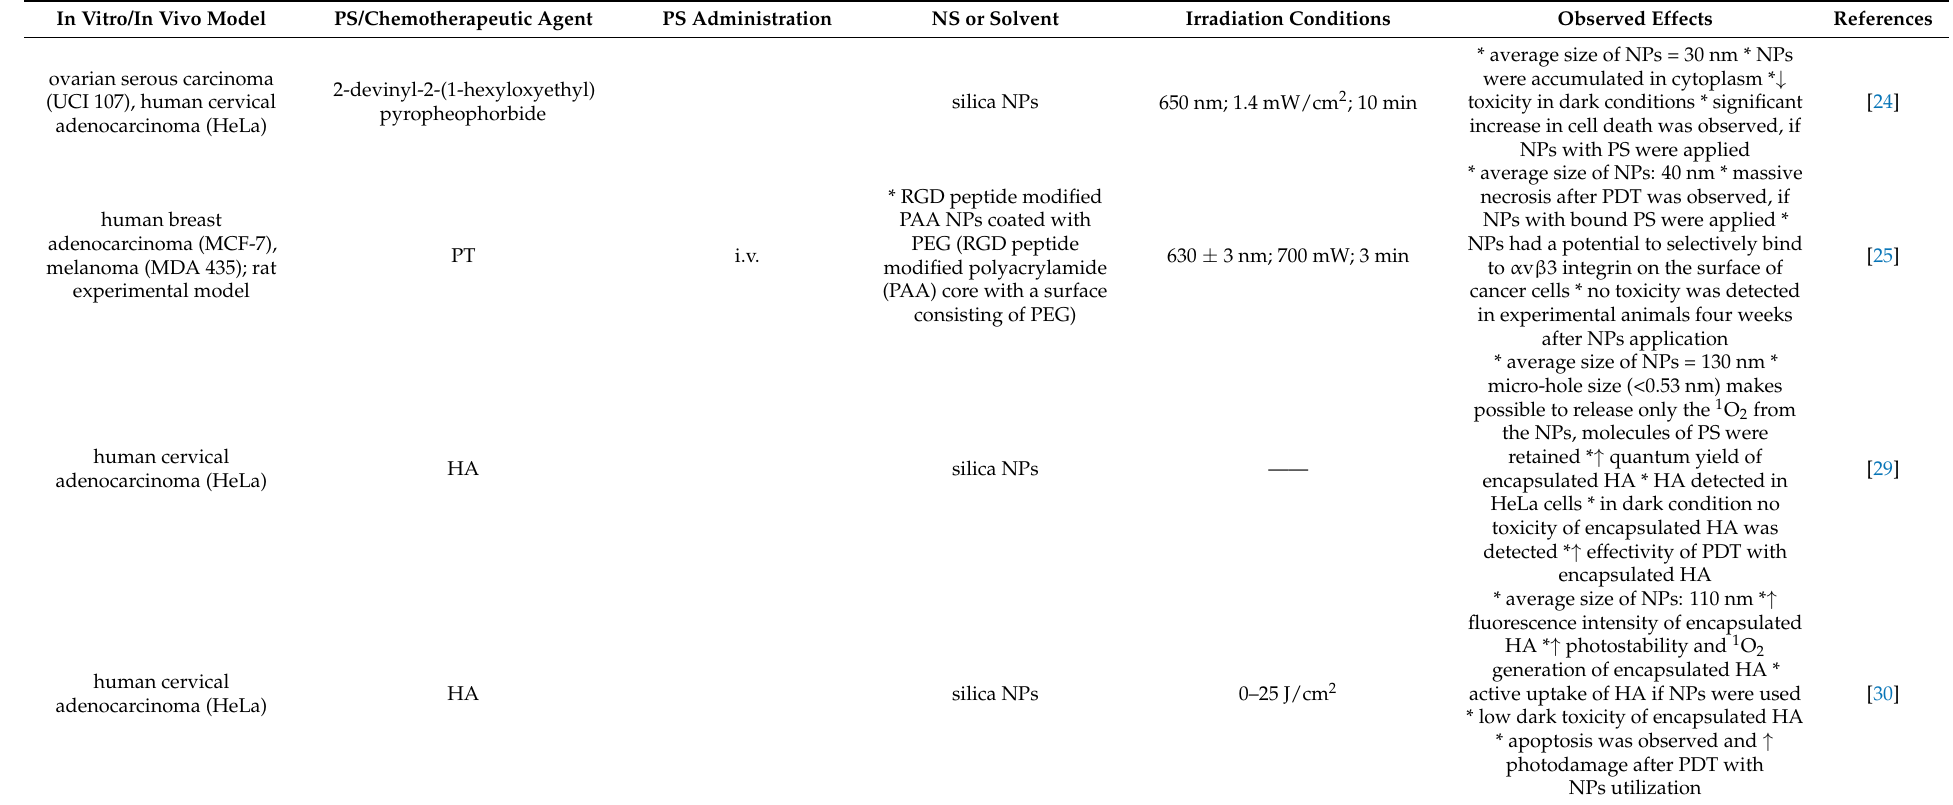
Table 1. Application of silica NPs for PDT in the context of